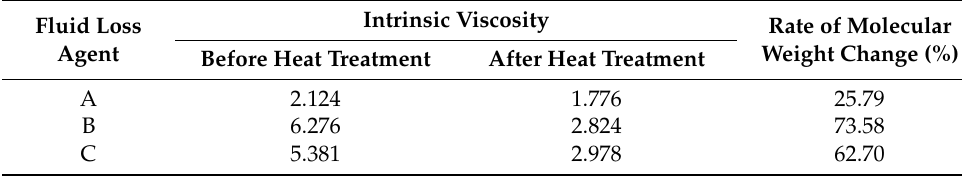
Table 4. Rate of change in molecular weight of fluid loss agent.